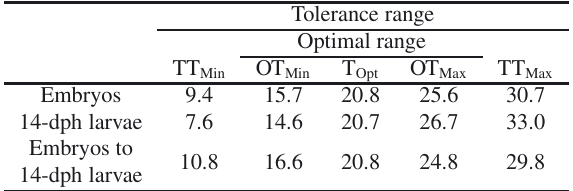
Table 1. Temperature thresholds for embryos, 14-dph larvae and from fertilization to 14-dph larvae. Optimal temperature (T opt , i.e., temper- ature at maximum survival), tolerance temperature range (i.e., sur- vival greater than 5%, TT min and TT max ), and optimal temperature range (i.e., survival greater than 80%, OT min and OT max ). Tolerance range Optimal range